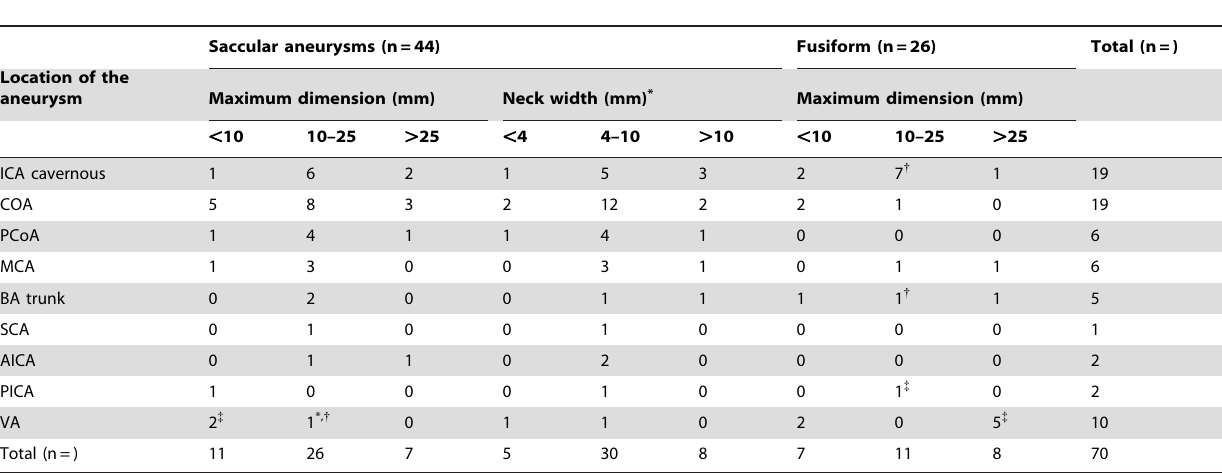
Table 1. Aneurysm locations presented as maximum sac size, neck width, and